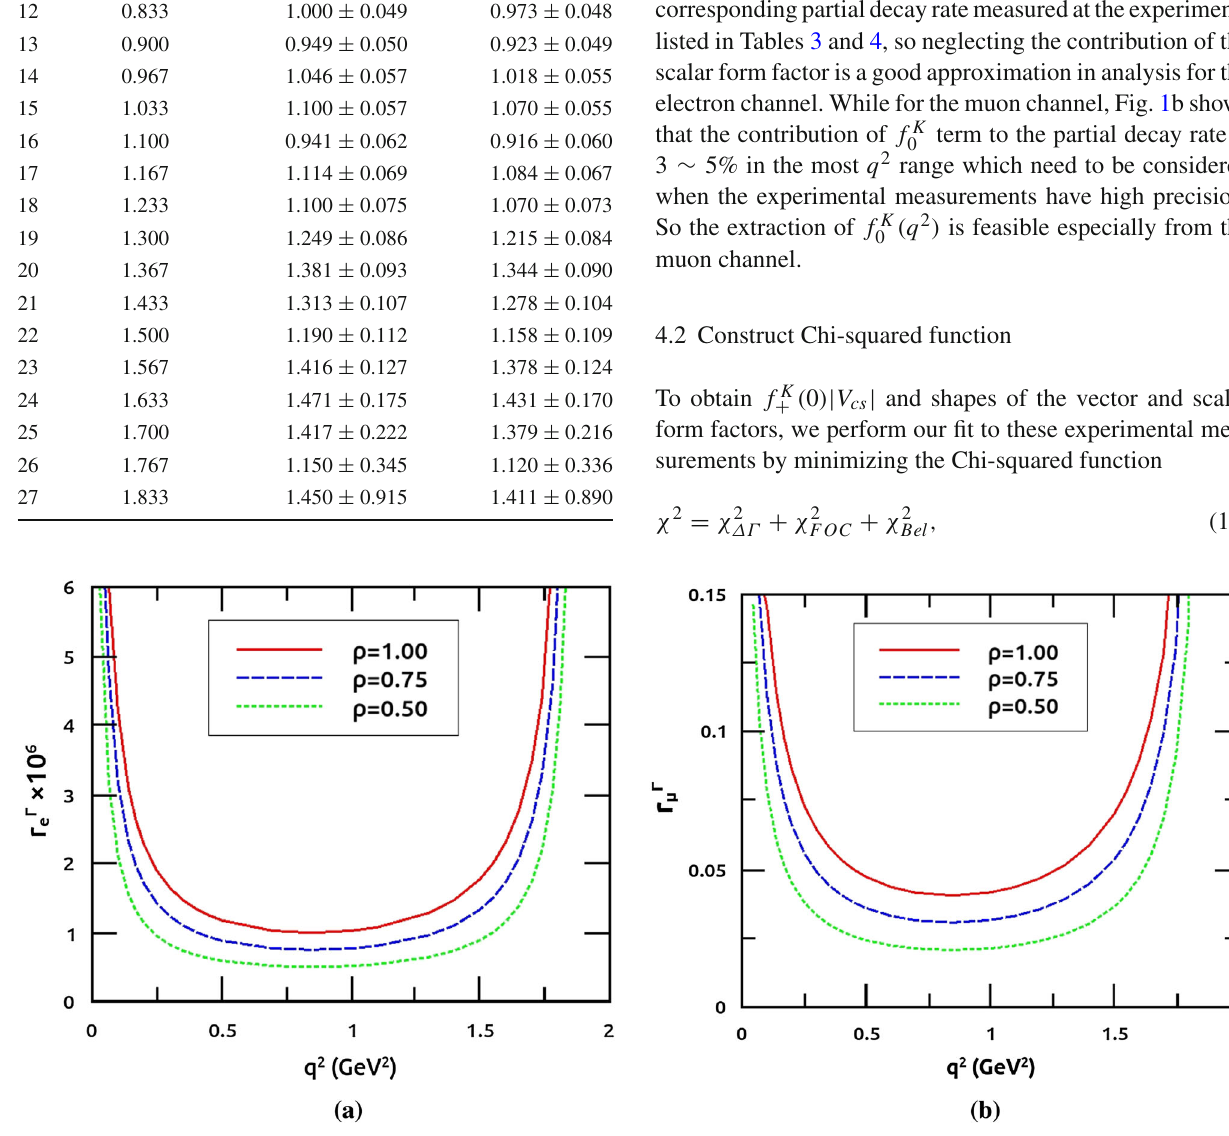
Fig. 1 The contributions of f 0 term to the differential decay rates for D → Ke + ν e decays (a) and D → K μ + ν μ decay